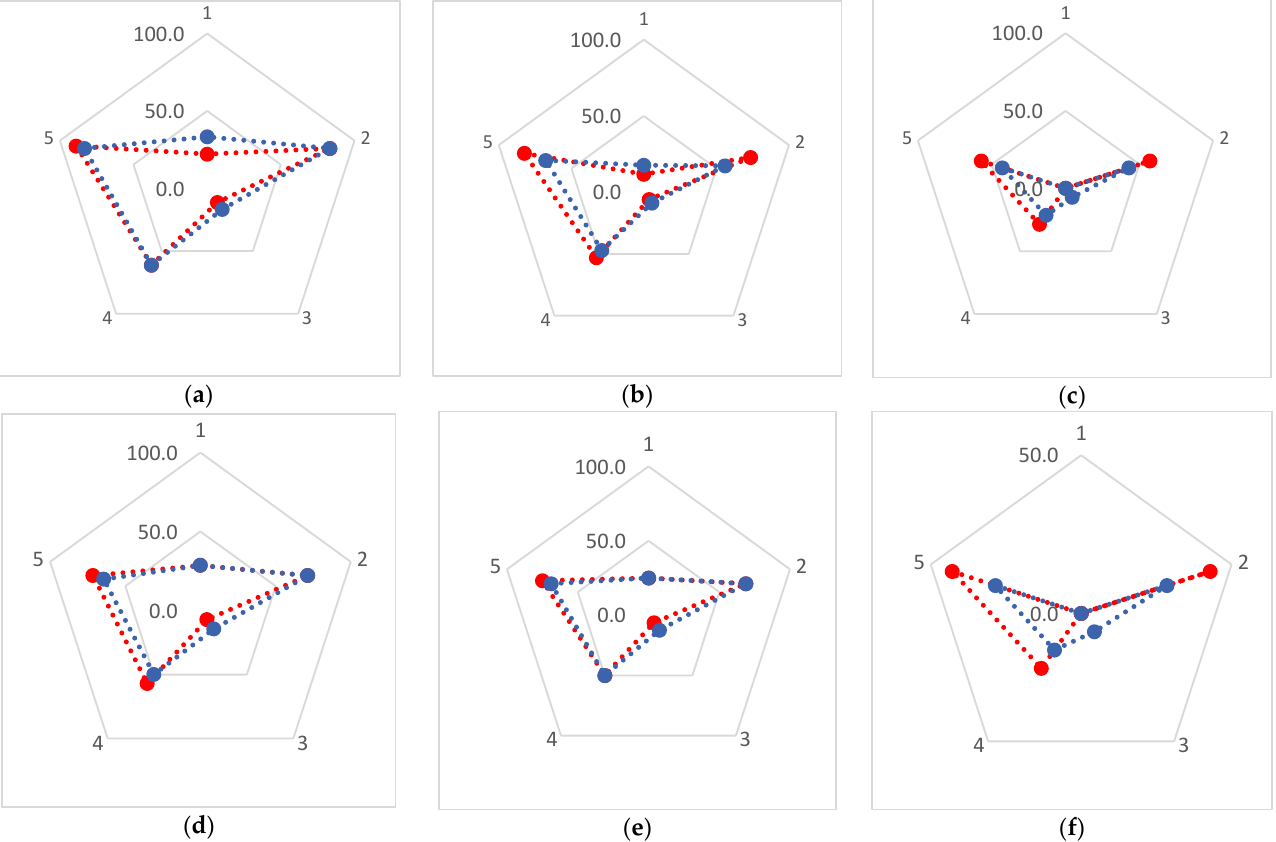
Figure 7. Percentage of points for Baroque-style park in 5 categories: ( a ) level 1; ( b ) level 2; ( c ) level 3. Percentage of points for Renaissance-style park in 5 categories: ( d ) level 1; ( e ) level 2; ( f ) level 3.